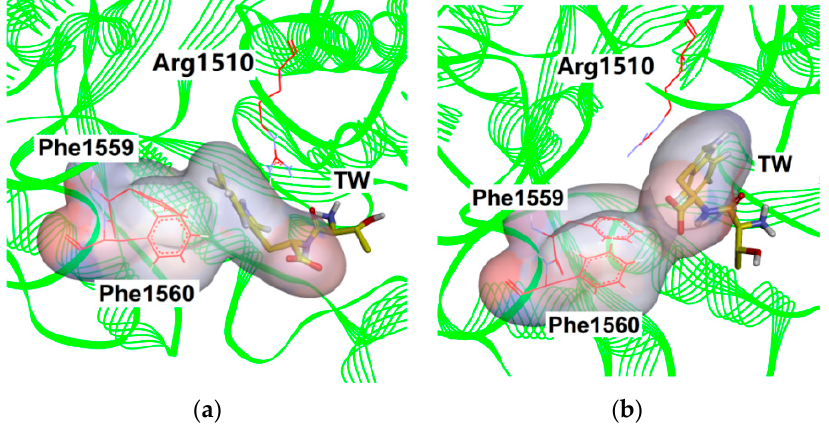
Figure 6. ( a ) Schematic diagram of the hydrophobic regions of MGAM ‐ TW before 27 ns and ( b ) schematic diagram of the hydrophobic regions of MGAM ‐ TW after 27 ns.